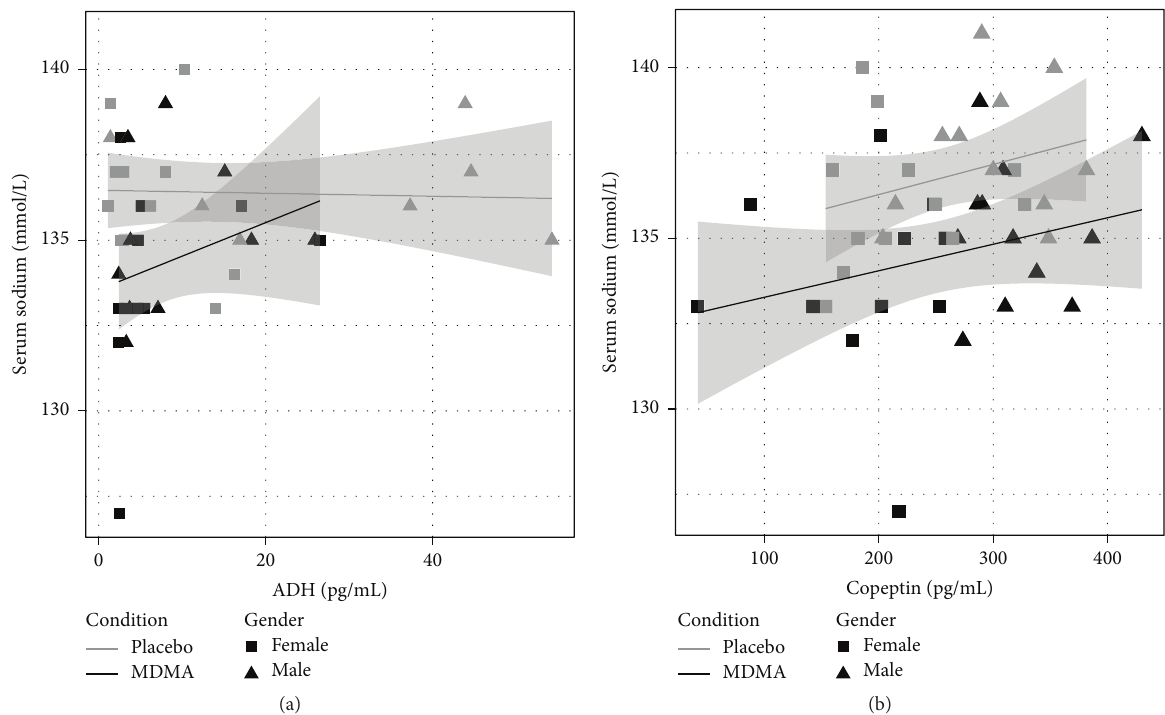
Figure 5: Relationships between antidiuretic hormone (ADH, (a)), copeptin (b), and serum sodium at 2 and 3h after MDMA (black) or placebo (grey) in Study 2. Shaded regions indicate 95% confidence intervals of the mean as estimated with a linear model.